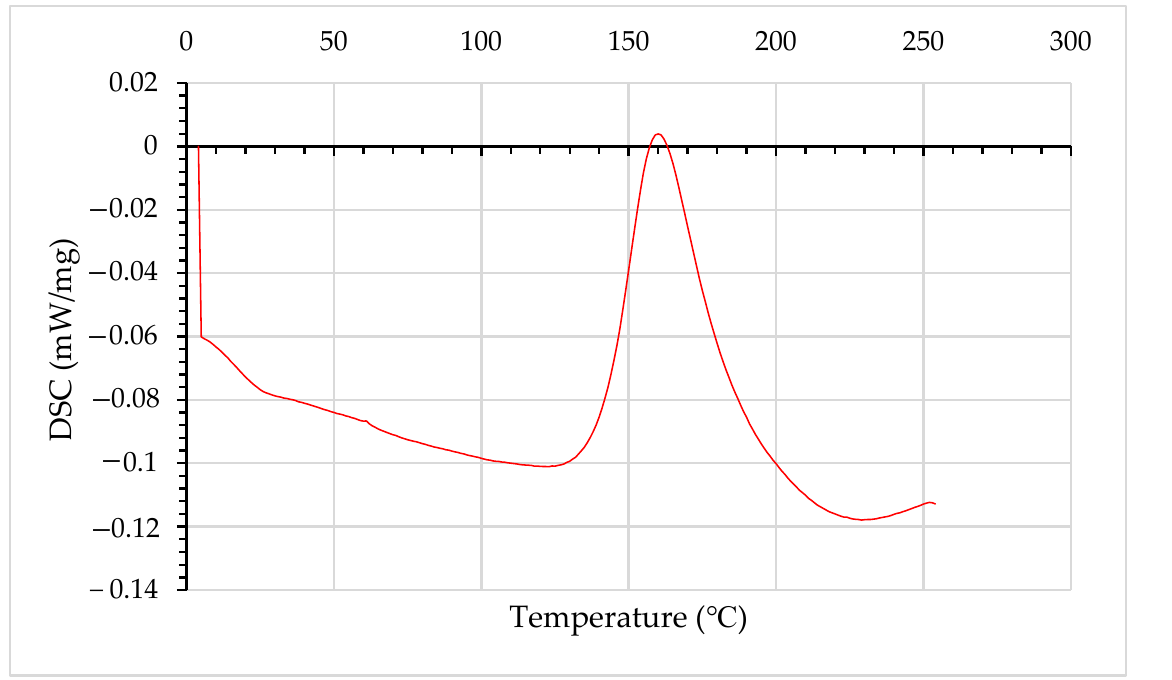
Figure 1. Differential scanning calorimetry, showing a peak at 155 °C consistent with manufacturing information. Table 2. Stacking Sequence for Hybrid Fibre Samples.